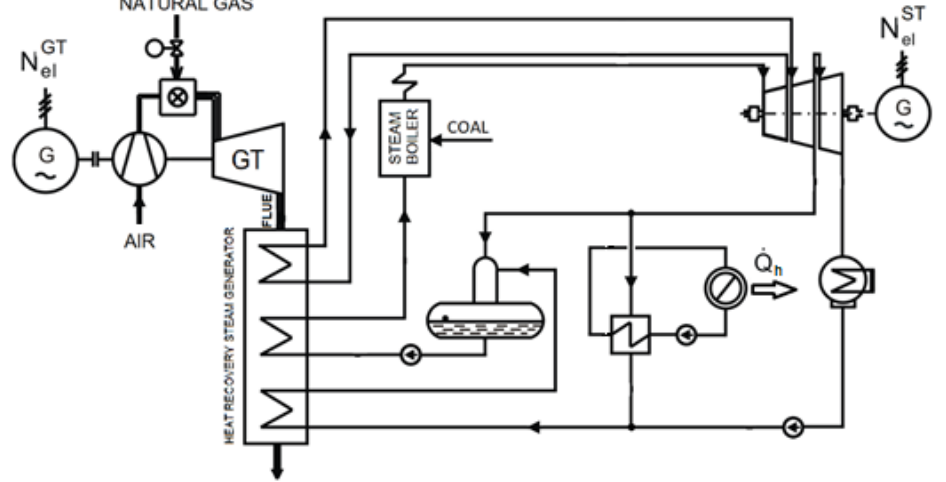
Figure 1. An example of a schematic diagram of a dual-fuel gas-steam combined heat and power (CHP) plant in a parallel system with extraction-condensing steam turbine.